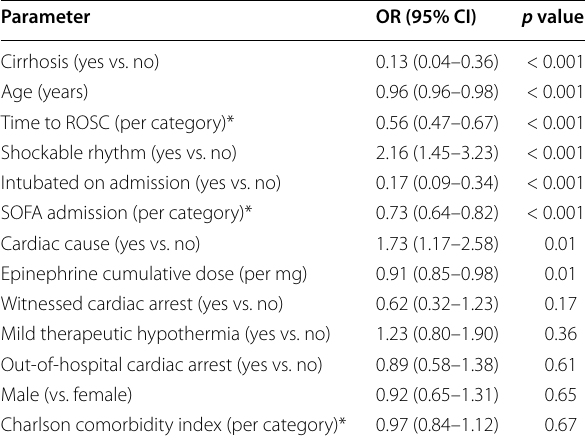
Table 3 Logistic regression model for factors associ- ated with good neurological outcome (CPC 1/2 vs. > 2 or